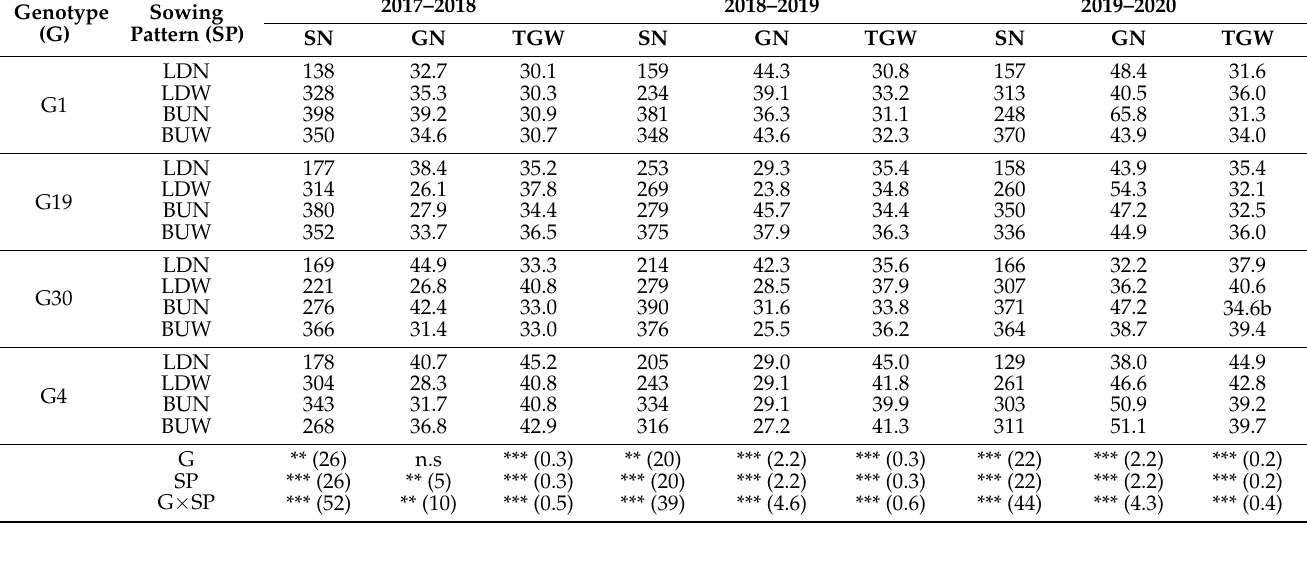
Table 3. The spike number (SN), grain number (GN) per spike and 1000-grain weight (TGW) of four wheat genotypes under four different sowing patterns during three consecutive growing seasons. LSD values at p = 0.05 are in parenthe-